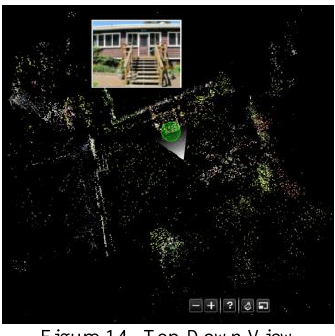
Figure 14 Top-Down